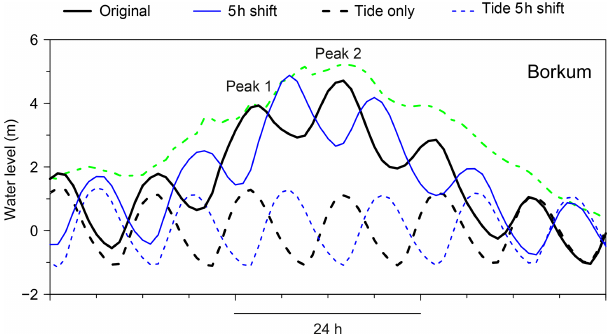
Figure 5. Highest event (EH): time series of the original (solid black line) and amplified water levels (solid blue line) for Borkum to- gether with tide-only time series (dashed black and blue lines); the amplification is due to 5-hourly shifting of the tide. The dashed green curve represents the effective wind (scaled from − 10 to 30ms − 1